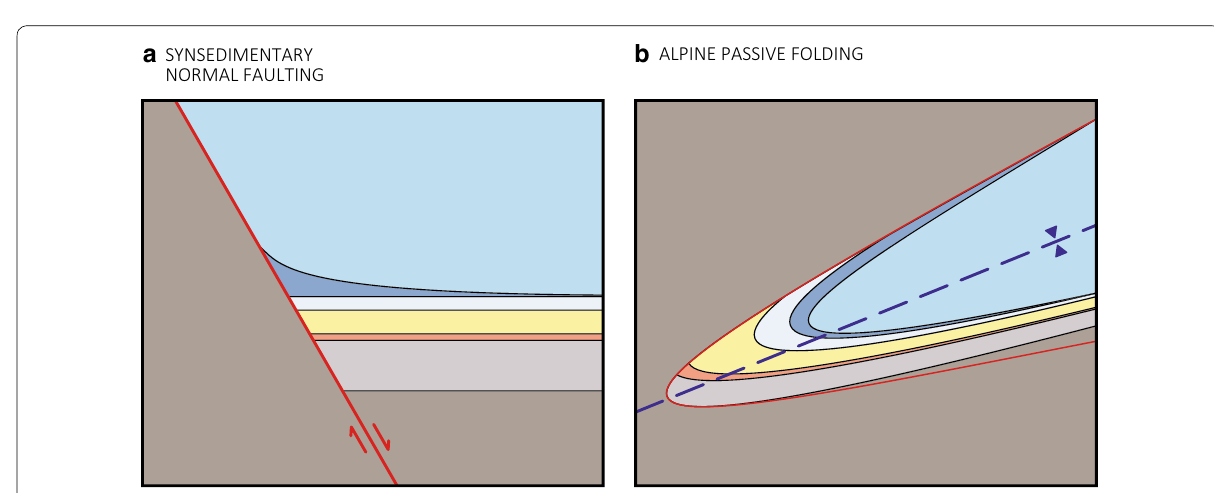
Fig. 13 Conceptual model of passive deformation of a pre‑existing discordance. a Initial geometry resulting from the movement of a high‑angle synsedimentary normal fault. b Transformation of the initial geometry by heterogeneous simple shear (sinusoidal function). Modeling was performed using the Shear2F software (Rey